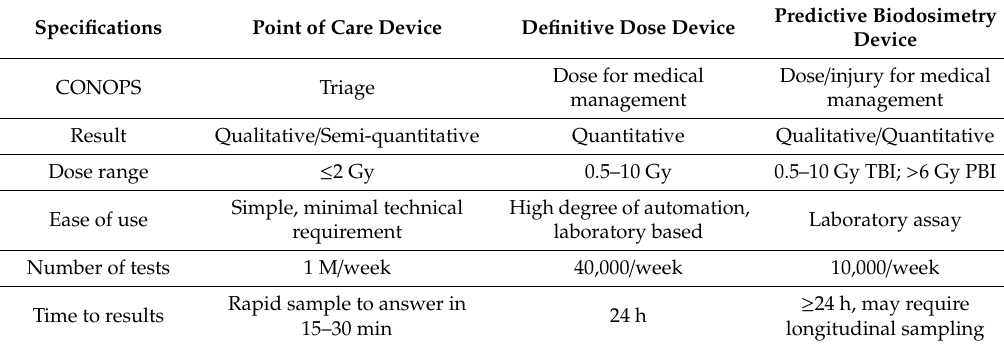
Table 1. Attributes for biodosimetry approaches being developed by NIAID /